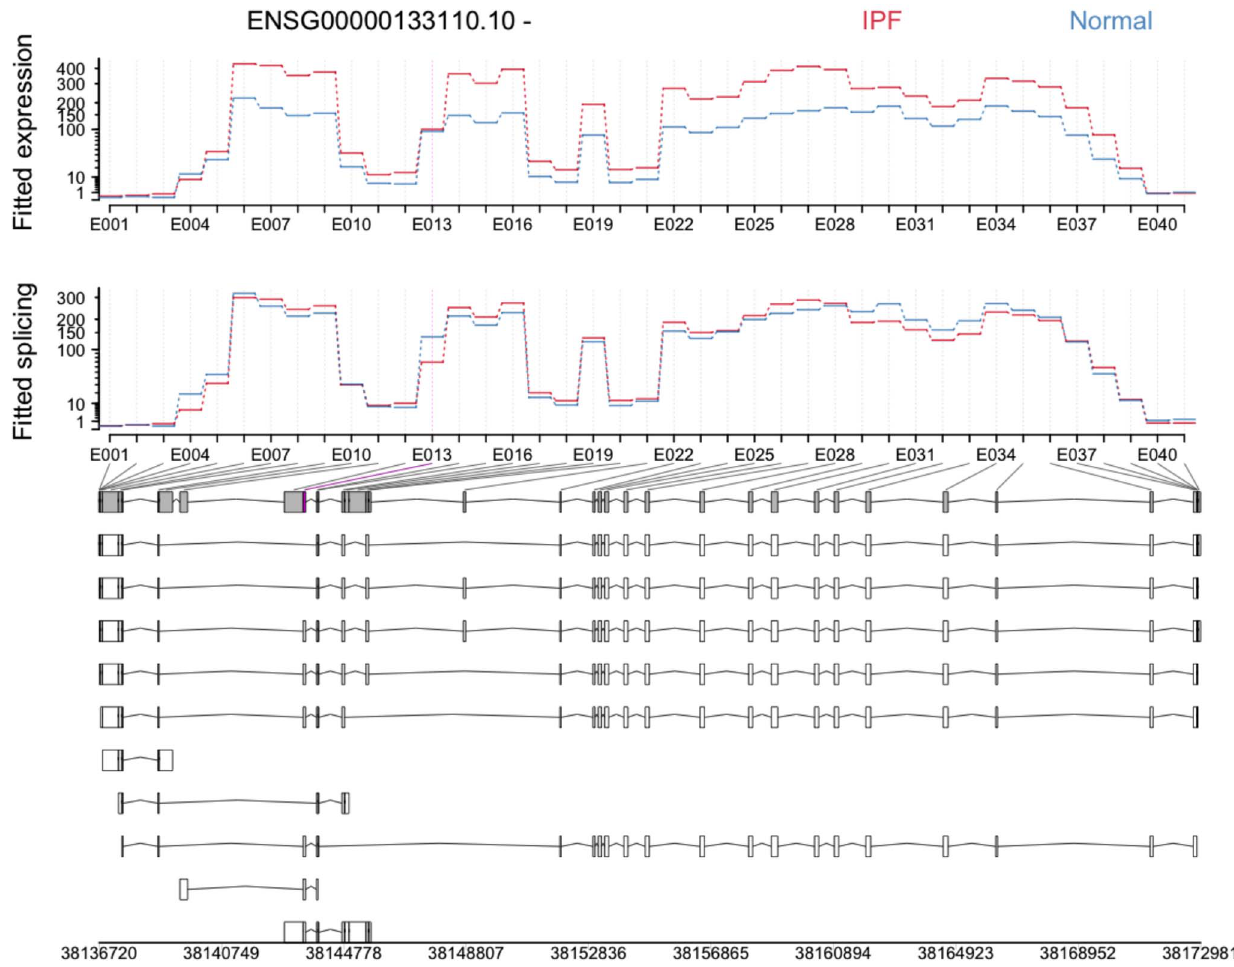
Figure 5. Periostin (POSTN) shows evidence of differential splicing at exon 21. In this splicing plot produced by DEXSeq, exon 21 (labelled E013) is highlighted in